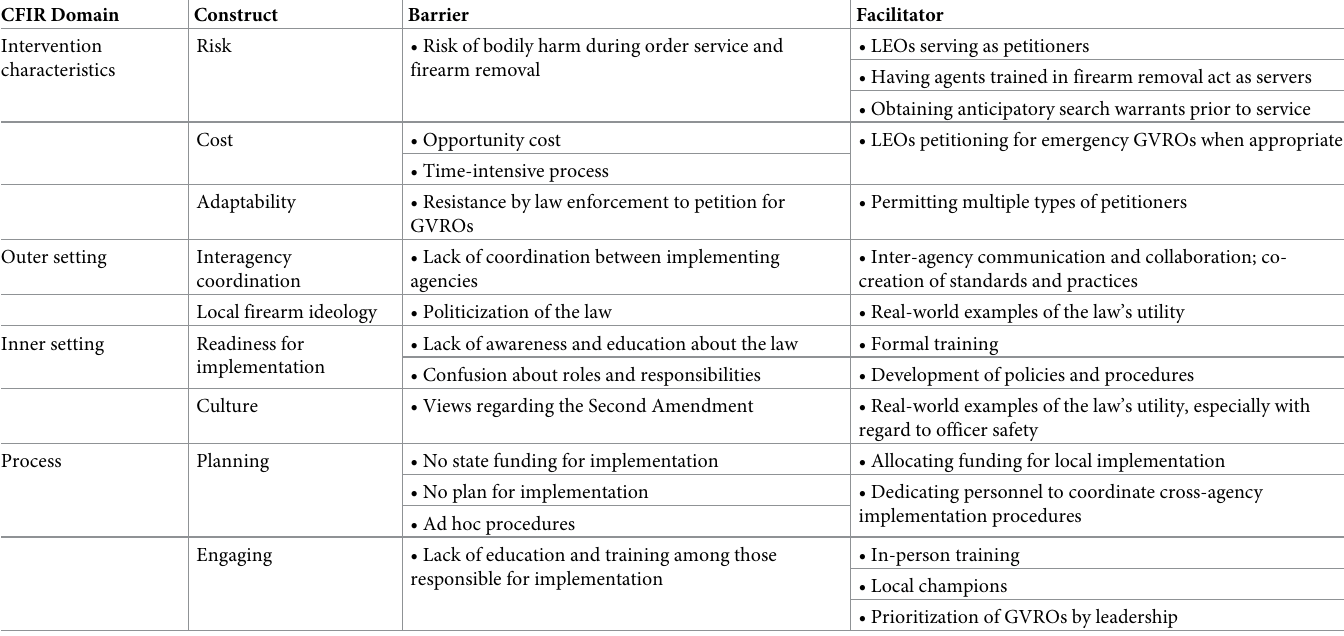
Table 2. Contextual considerations for GVRO implementation by CFIR domain and